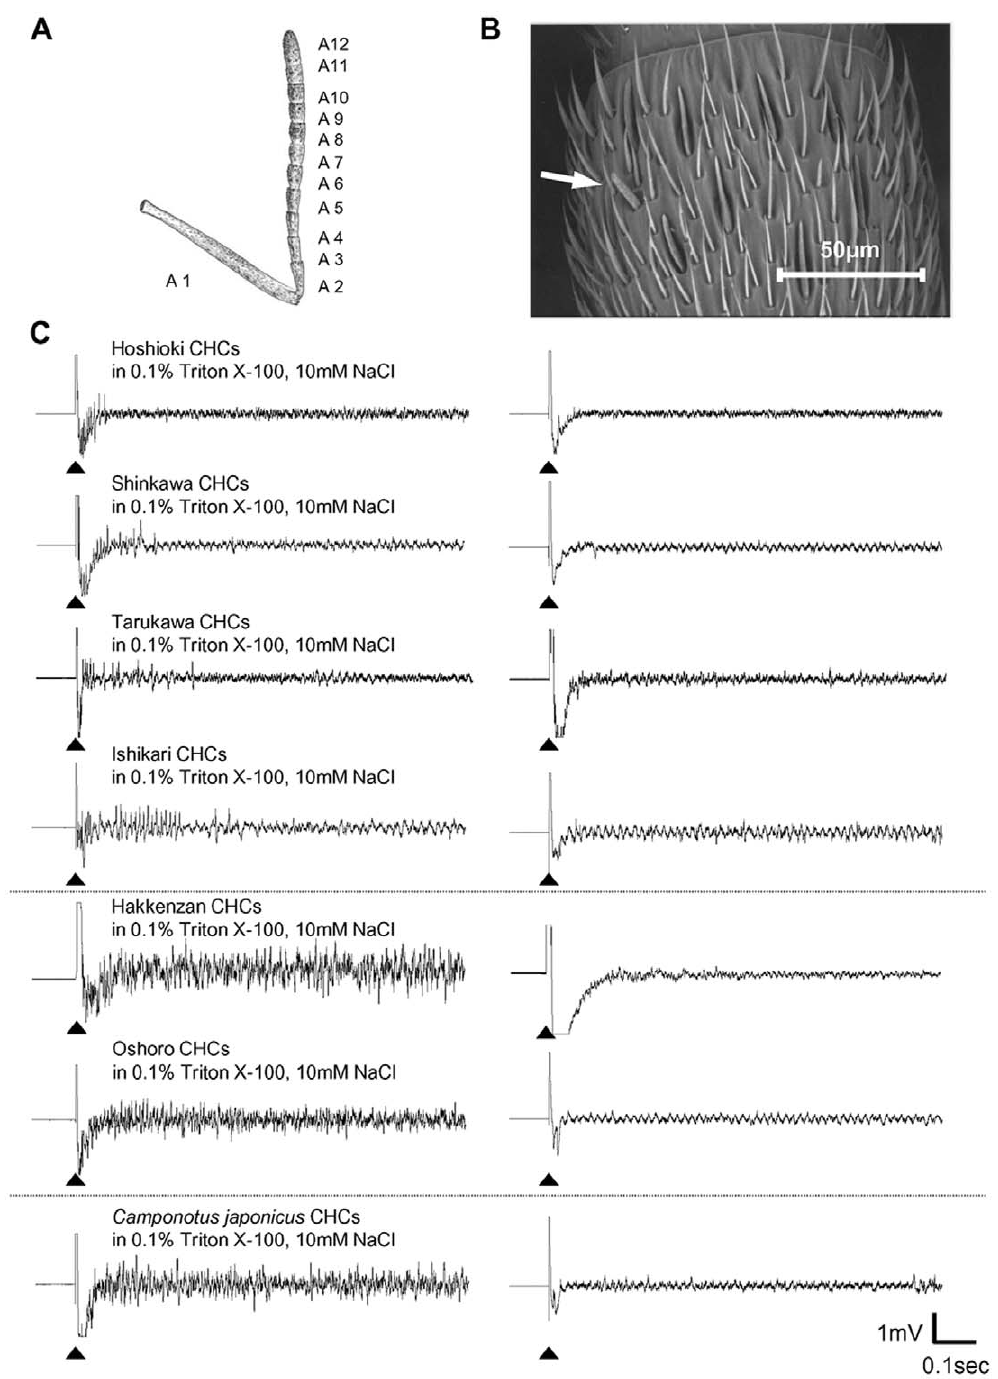
Figure 3. Electrophysiological responses from the CHC sensilla. ( A ) Schematic drawing of an antenna of F. yessensis ; A1, scape; A2–12, funiculus segments. ( B ) Scanning electron micrograph (SEM) of the antennal surface of A7. A CHC sensillum is indicated by an arrow. ( C ) Left: Representative electrophysiological responses from CHC sensilla of ‘‘Hoshioki’’ workers, when stimulated with CHCs extracted from workers of nests within and outside the ‘‘Ishikari supercolony’’ of F. yessensis and workers of C. japonicus (Stimulus CHCs were dissolved in 10 mM NaCl plus 0.1% Triton X-100). Right: Control recordings of the same sensilla, when stimulated with the solvent, 10 mM NaCl plus 0.1% Triton X-100. Arrowheads indicate beginning of stimulation. doi:10.1371/journal.pone.0046840.g003 ‘‘Shinkawa’’ CHCs, 0.5 ant equivalent of ‘‘Hakkenzan’’ CHCs, or ‘‘Hoshioki’’ workers toward ‘‘Shinkawa’’, ‘‘Hakkenzan’’ and C. japonicus CHCs were 1.5-, 10- and 100-fold lower than that to 0.05 ant equivalent of C. japonicus CHCs. This indicated that the mean threshold amounts of CHCs for eliciting biting behavior of nestmate CHCs, respectively. Even when we correct for the